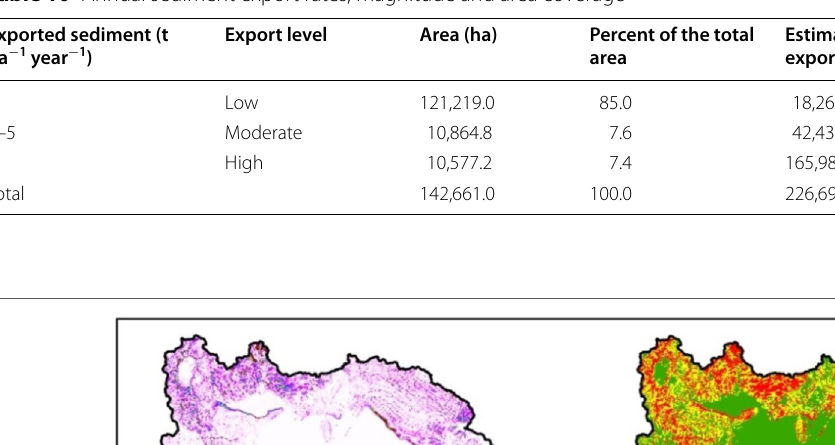
Table 10 Annual sediment export rates, magnitude and area coverage